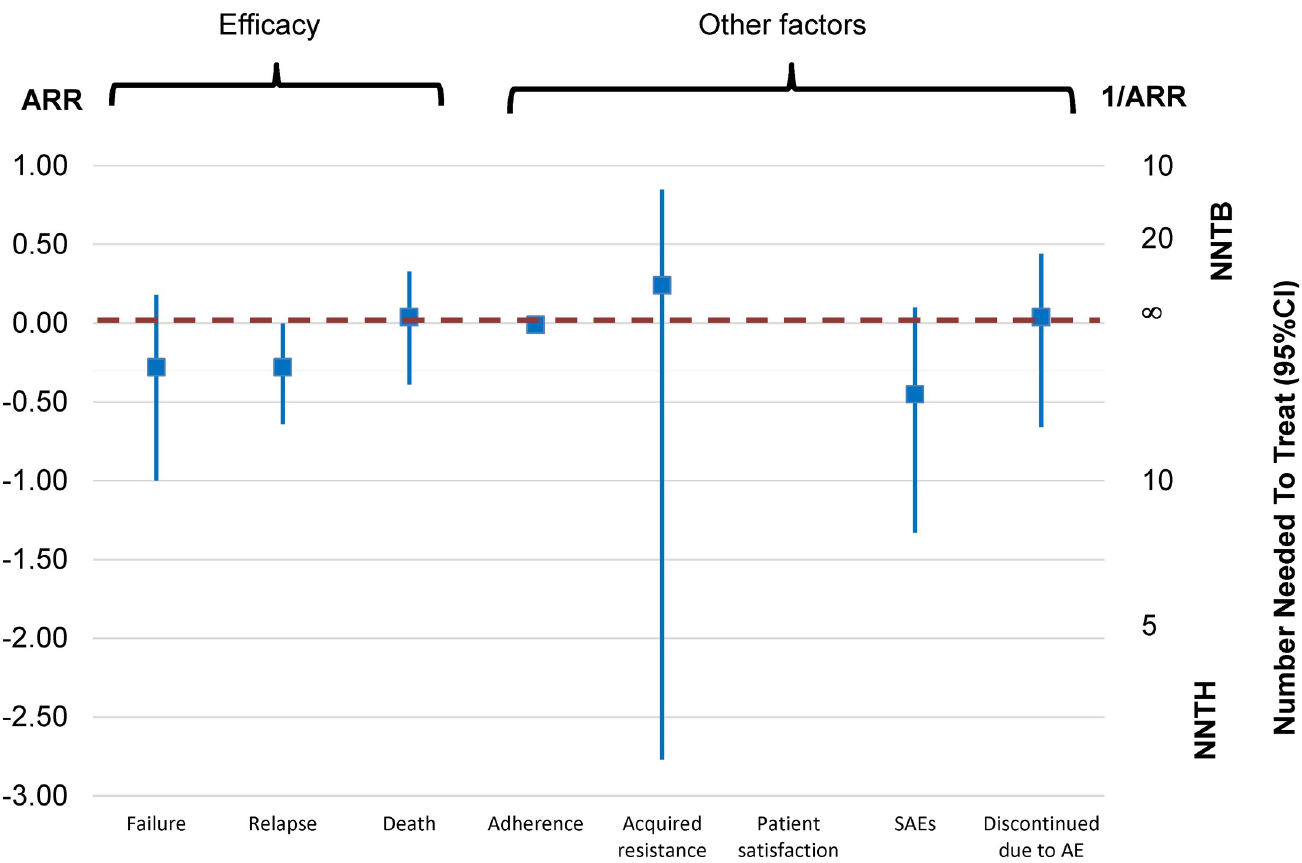
Fig 6. Plotting efficacy outcomes and examples of other relevant factors contributing to weigh gains and losses—Cochrane systematic review and meta-analysis of fixed-dose versus loose combinations [43]. AE, adverse event; ARR, absolute risk reduction; CI, confidence interval; NNTB, number needed to treat for one patient to benefit; NNTH, number needed to treat for one patient to be harmed; SAE, serious adverse